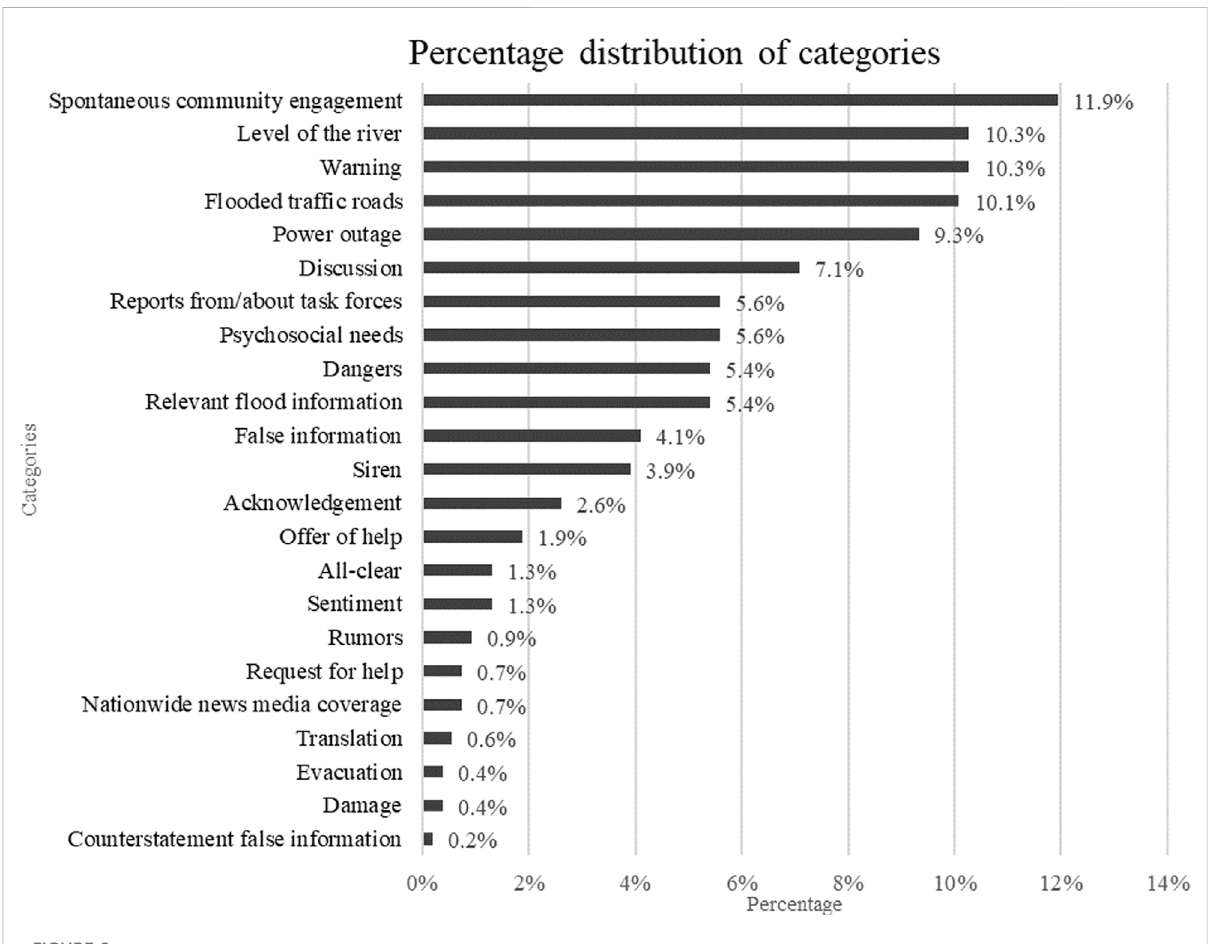
FIGURE 2 Percentage distribution of